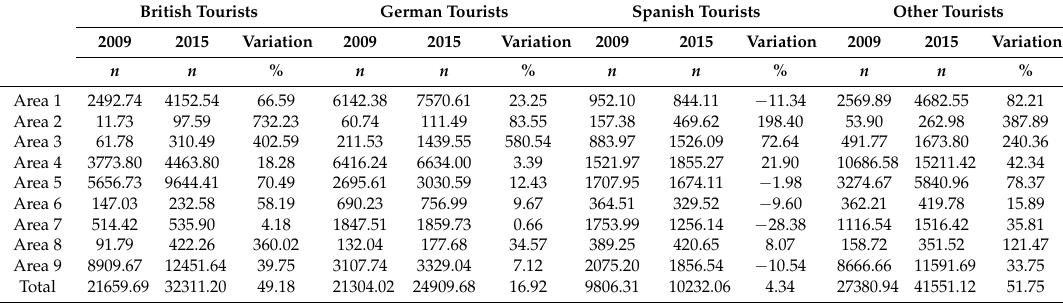
Table 2. Tourist overnight stays (thousands) and percent change in the rate between 2009 and 2015 by nationality and area of